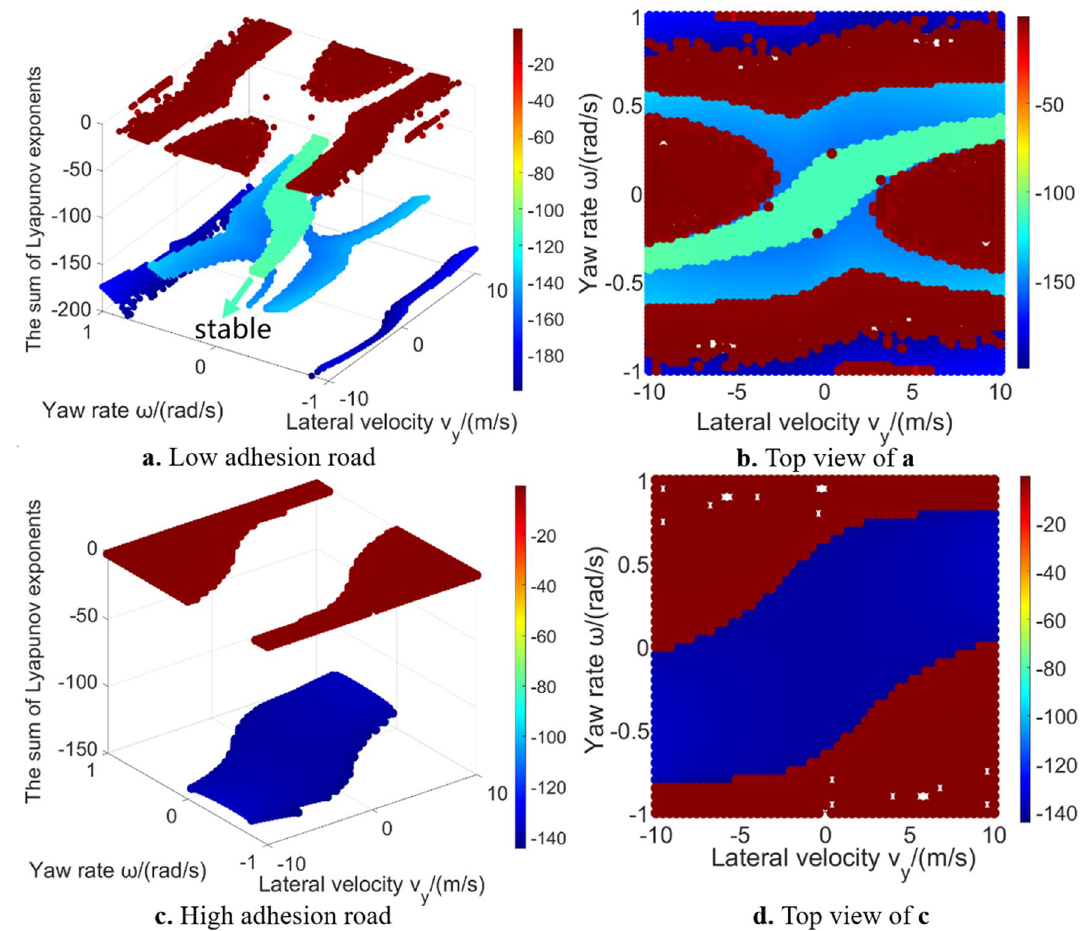
Figure 14. The sum of Lyapunov exponents in 5-DOF model global